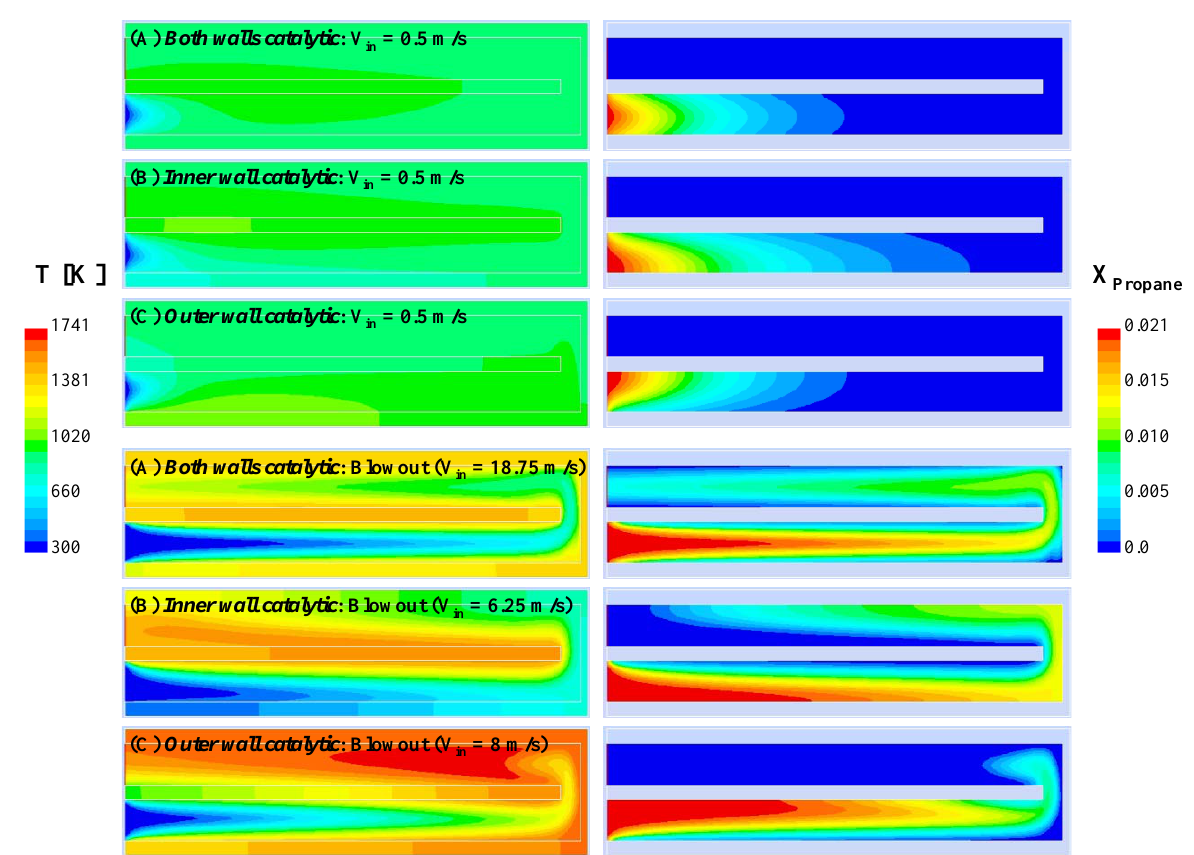
Figure 9. Contours of temperature, T [K], and propane mole fraction, X Propane , at V in = 0.5 m/s and (near) blowout for the three reactor configurations of Figure 1 with different catalyst placement. High thermal conductivity (30 W/(m K)). The computational domain is scaled along the transverse direction by a factor of